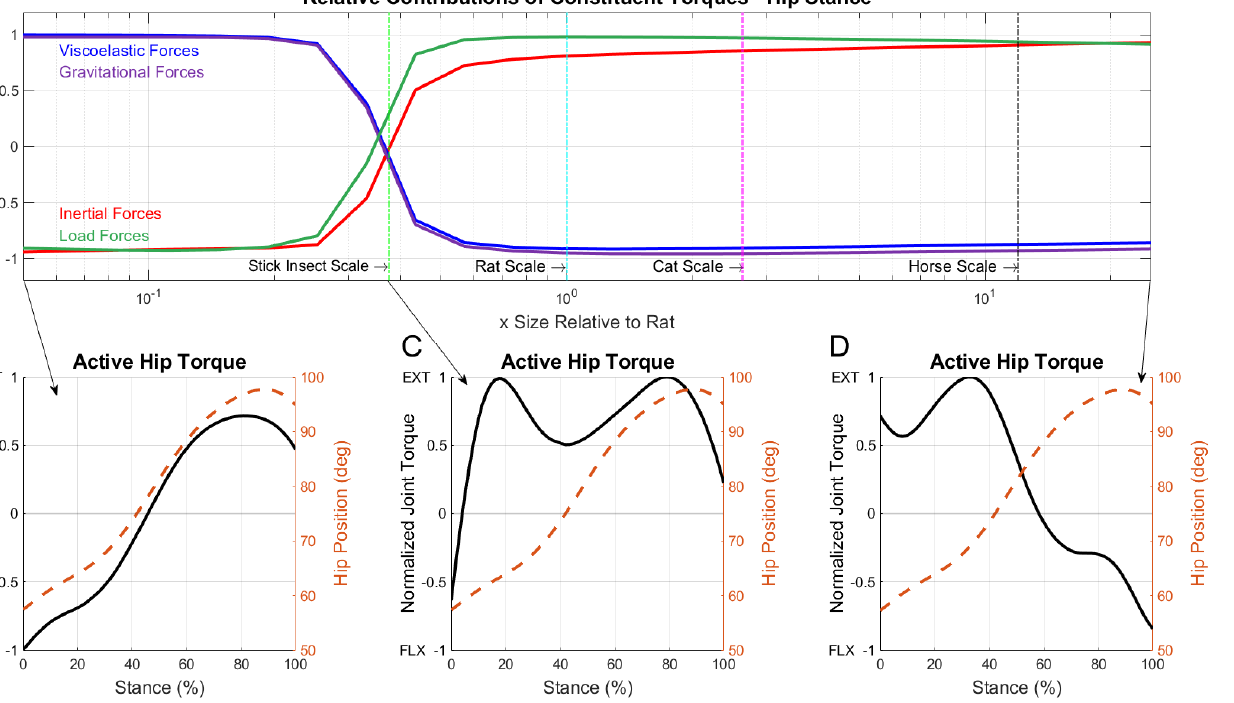
Figure 7. ( A ) Linear correlation coefficient values between constituent torques compared with active torque for the hip joint during stance phase. Viscoelastic (blue), inertial (red), gravitational (purple), and load (green) waveforms represent the linear correlation coefficients of each constituent torque relative to active muscle torque. Individual animal sizes are indicated by vertical lines for the model at the scale of a stick insect, rat, cat, and horse. ( B ) Stance phase active joint torques for the hip at three size-scales. Solid lines indicate the normalized joint torque and dashed lines indicated the hip position in degrees. Active joint torque is shown for an animal at 0.05x rat size. The crossover point where viscoelastic and inertial contributions are equal ( C ), and an animal at 25x rat size ( D ). Once again, the kinematics are almost identical across scales but the relationship between the joint movement and the peak joint torque changes significantly with the scale. See text.